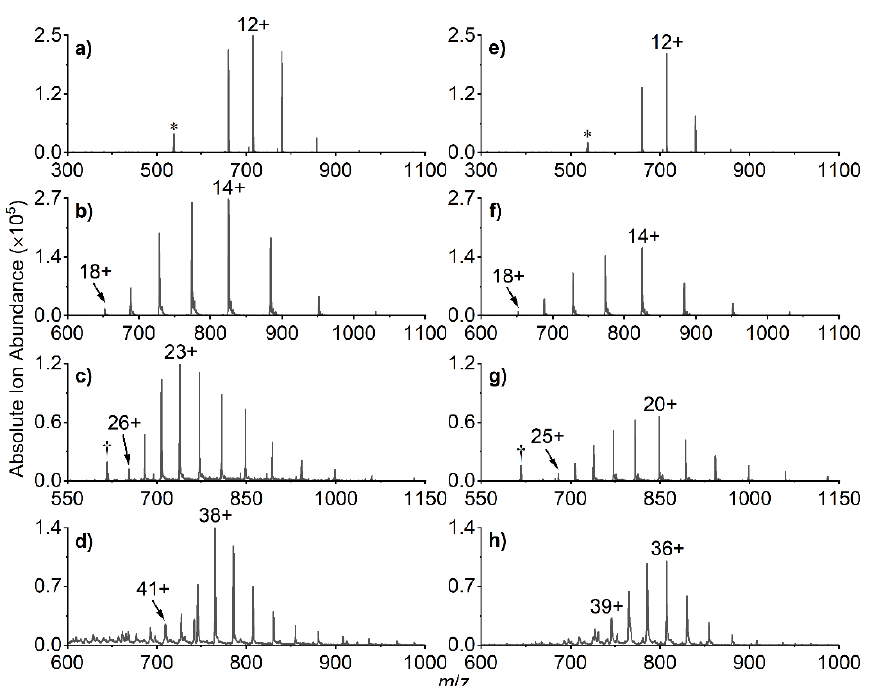
Figure 2. Mass spectra of ubiquitin (3 µM) ( a , e ), cytochrome C (5 µM) ( b , f ), myoglobin (5 µM) ( c , g ), and carbonic anhydrase (5 µM) ( d , h ) obtained from pulsed ( a – d ) and conventional direct current nESI ( e – h ), respectively. The pulsed nESI spectra were collected at an ‘optimum’ frequency of 200 kHz. † The heme group of myoglobin; * peaks corresponding to the chemical noise that are present in the solution blank. Table 1. Background chemical noise ( N C ), signal-to-background chemical noise ( S / N C ), and average charge state for angiotensin II, ubiquitin, cytochrome C, myoglobin, and carbonic anhydrase II calculated from pulsed and conventional direct current nESI mass spectrometry.